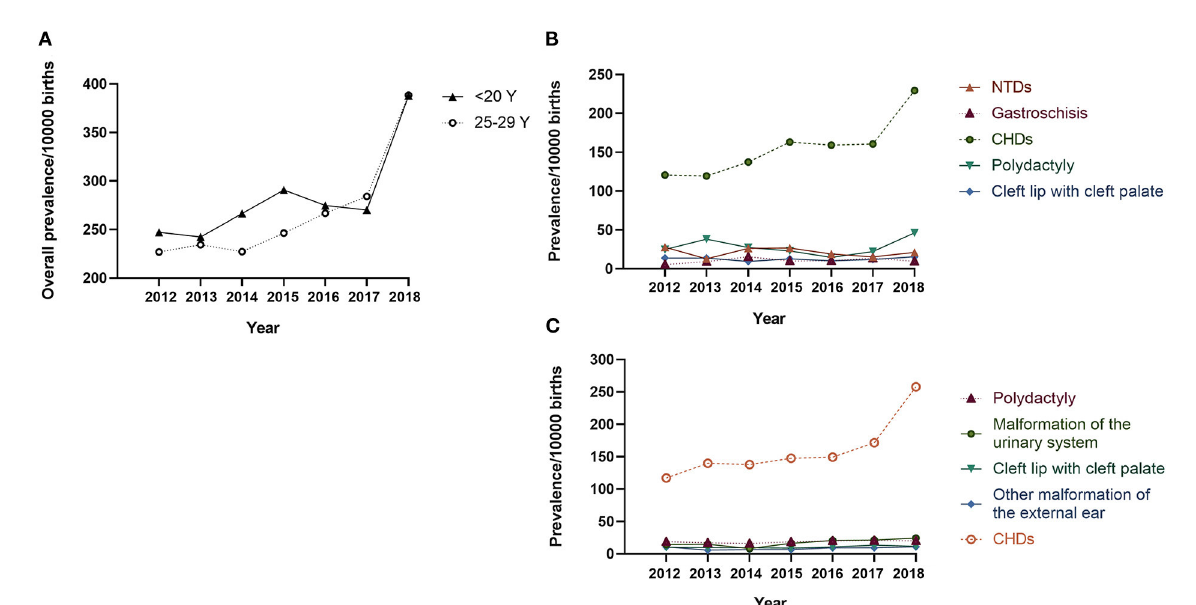
FIGURE1 Prevalence of birth defects in teenage pregnancies per 10,000 births: 2012–2018 Legend: (A) The solid line indicates the prevalence of overall BDs in infants born to mothers < 20 years old, and the dotted line indicates the prevalence of overall BDs in infants born to mothers aged 25–29 years; (B) Prevalence of the top-five BD subtypes in infants born to mothers < 20 years old; (C) Prevalence of the top-five BD subtypes in infants born to mothers aged 25–29 years. CHD, congenital heart defect; NTD, neural tube